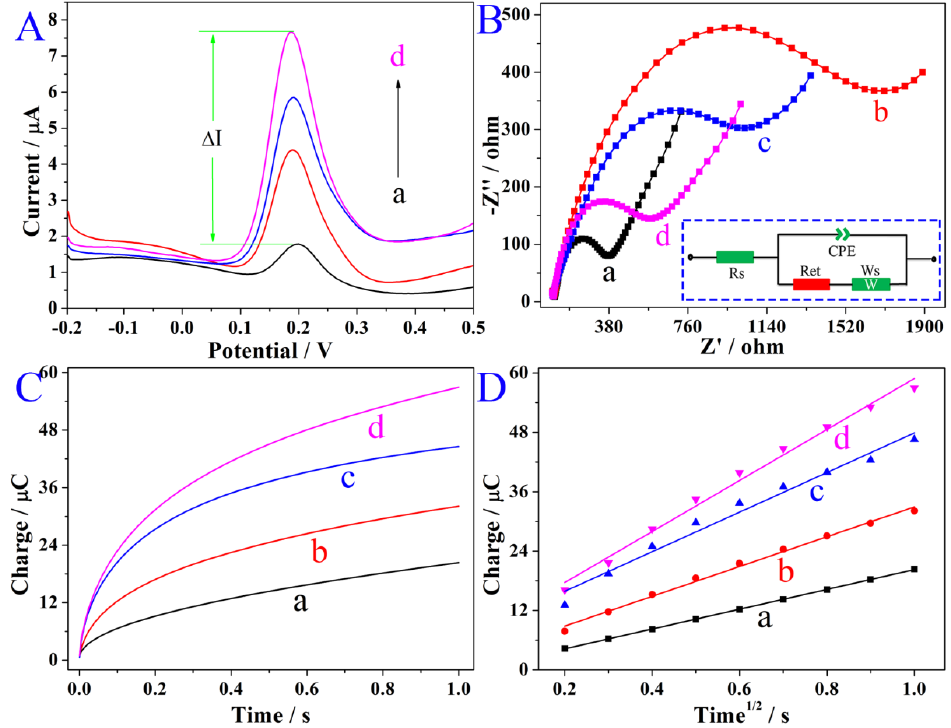
Figure 4. The SWV ( A ) of GCE (a), Cs/GCE (b), MoS 2 /GCE (c), Cs@MoS 2 /GCE (d), and Cs@MoS 2 -Pd NPs/GCE (e); the EIS ( B ) of GCE (a), MoS 2 /GCE (b), Cs@MoS 2 /GCE (c), and Cs@MoS 2 -Pd NPs/GCE (d); chronocoulometry curves ( C ) of GCE (a), Cs/GCE (b), Cs@MoS 2 /GCE (c), and Cs@MoS 2 -Pd NPs/GCE (d); and plot of Q versus t 1/2 ( D ).